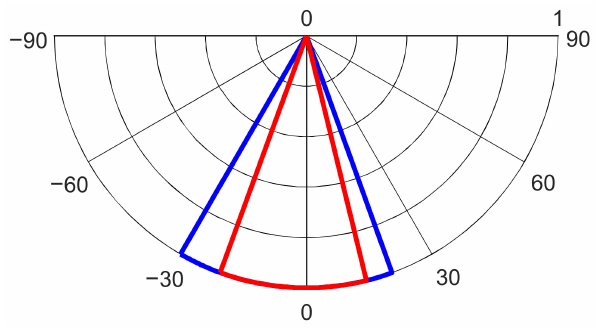
Figure 19. Possible controllable range of DP systems: (blue) SM and (red) PD